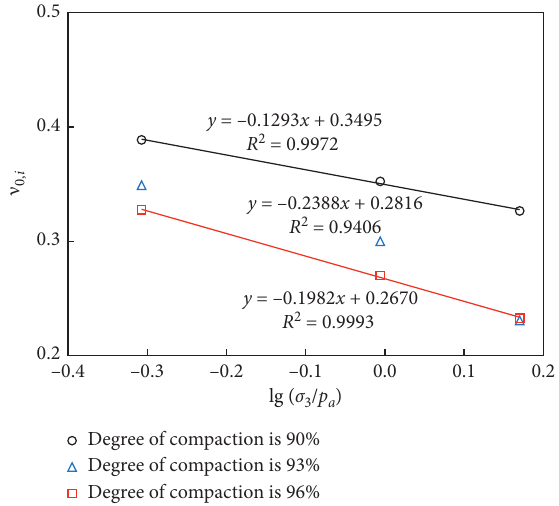
0, i /pa) and lg ( σ 3/pa).